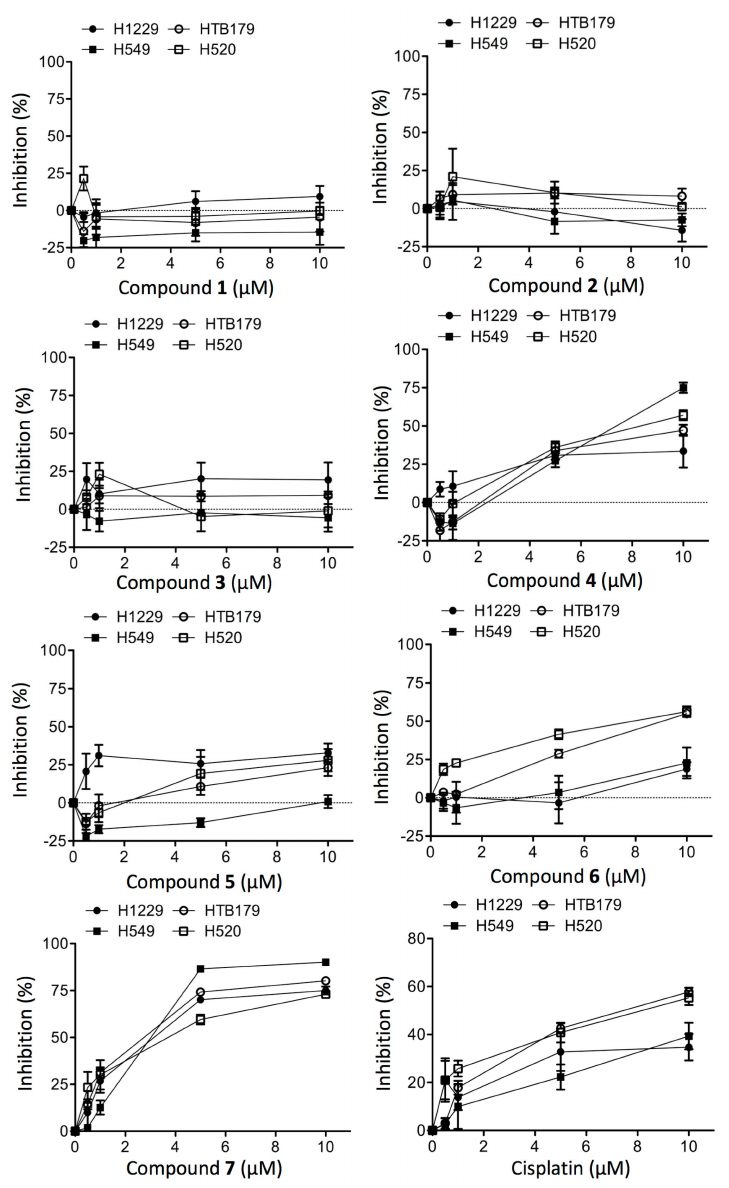
Figure 8. Inhibition of cell growth by compounds 1 – 7 as compared to cisplatin control in cultured human lung